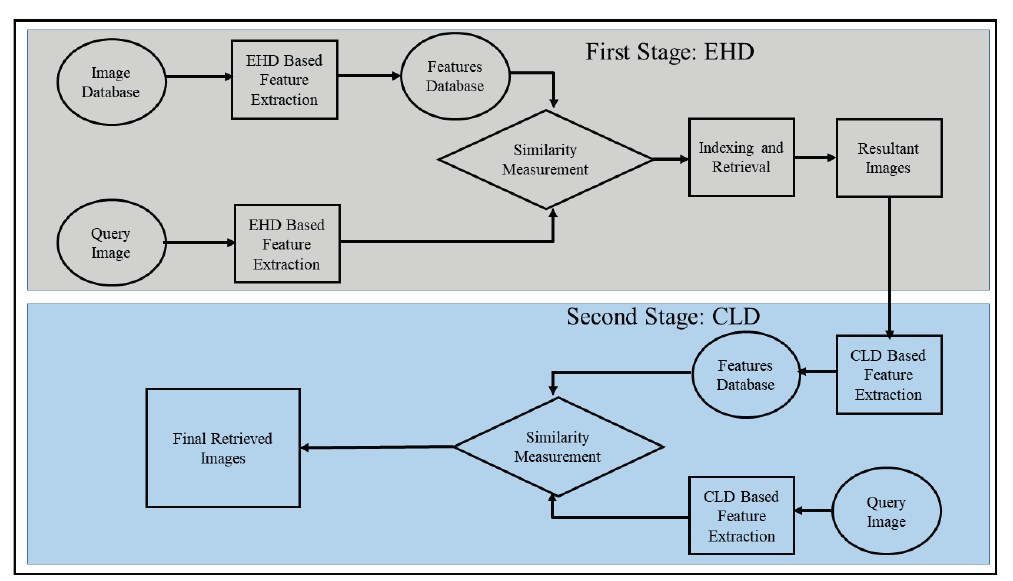
Fig. 6. EHD and CLD based CBIR.